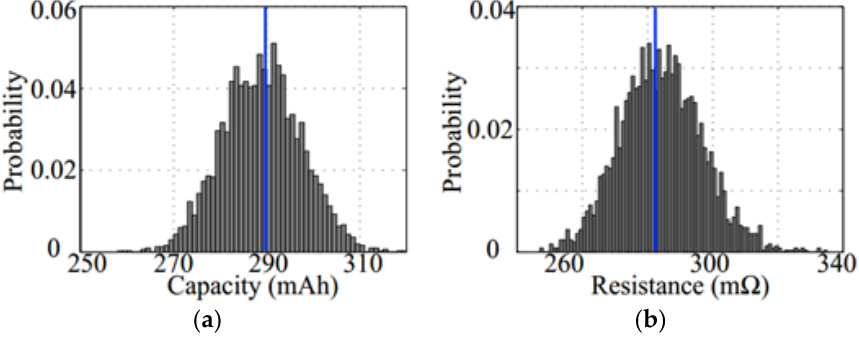
Figure 1. Probability distribution of the ( a ) cell capacity and ( b ) resistance profile of the sample cells. From [38].